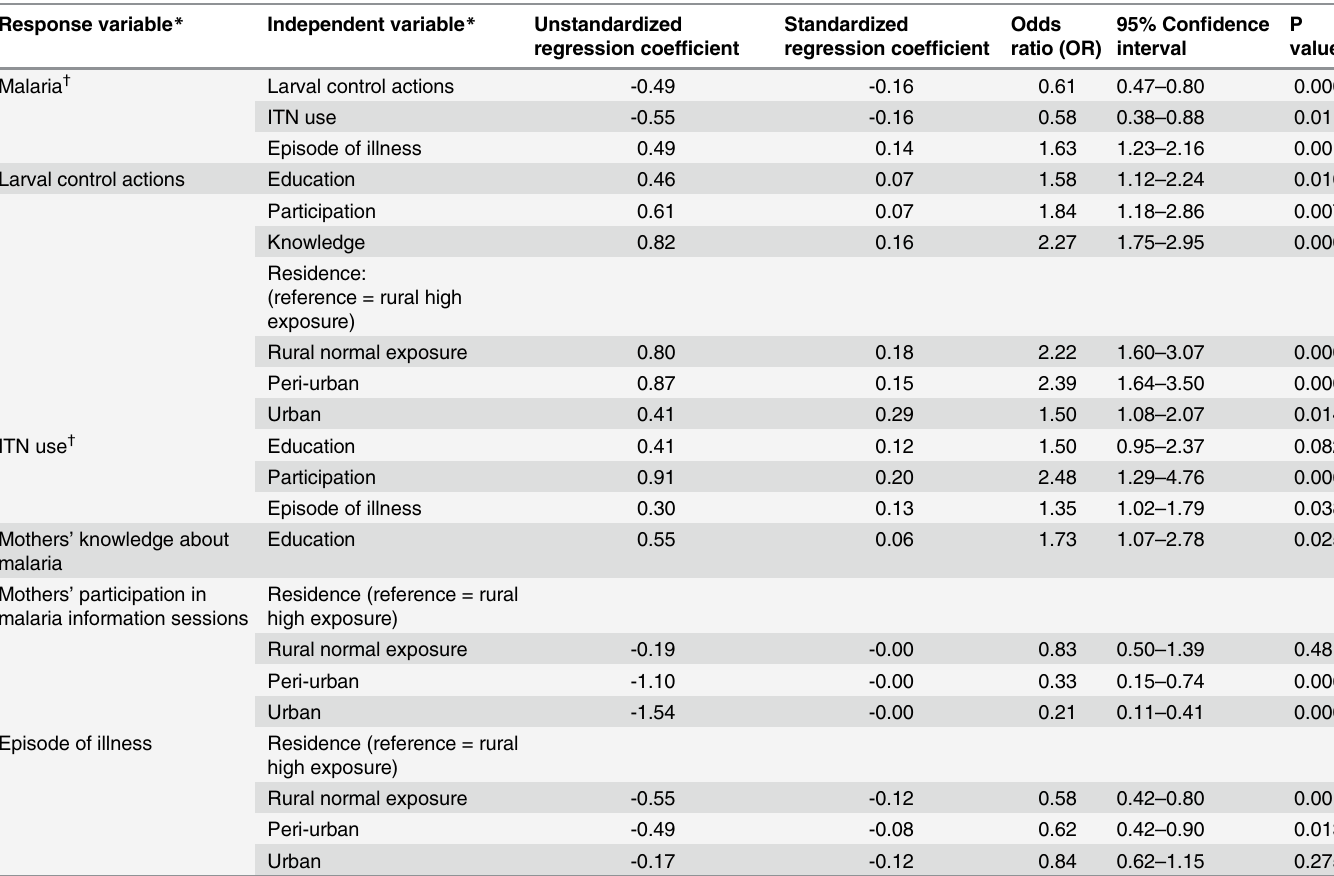
Table 4. Generalized structural equation models: relationship between knowledge, attitudes, and practices and malaria transmission among under-five children. Response variable